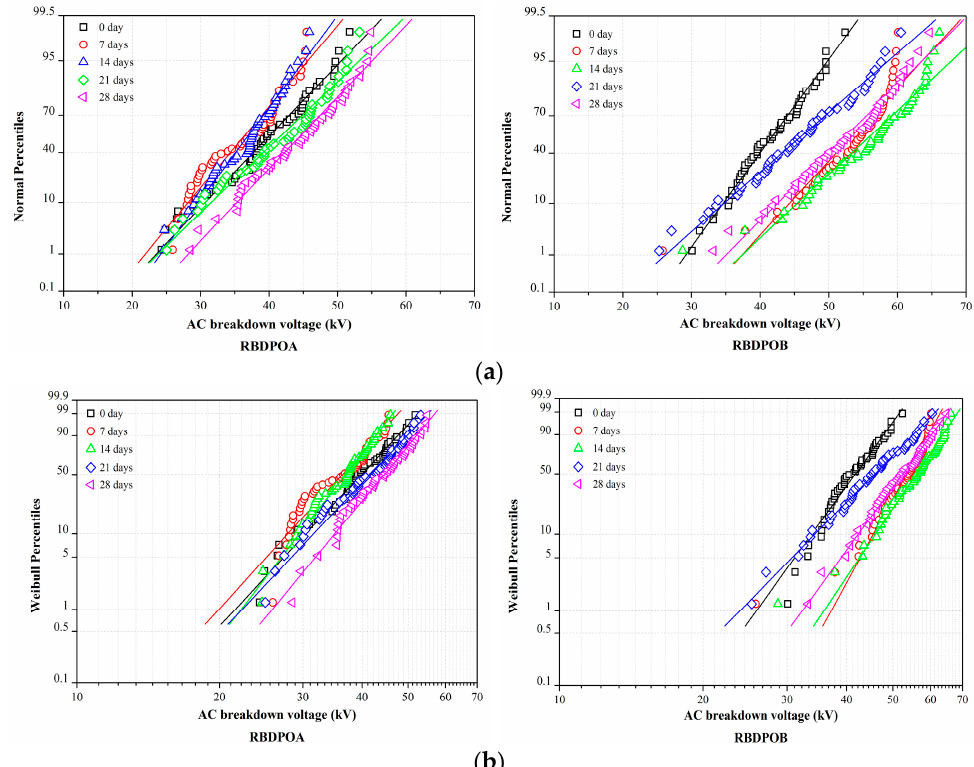
Figure 5. Probability plot of RBDPO aged at 170 °C under open conditions: ( a ) normal distribution and ( b ) Weibull distribution.